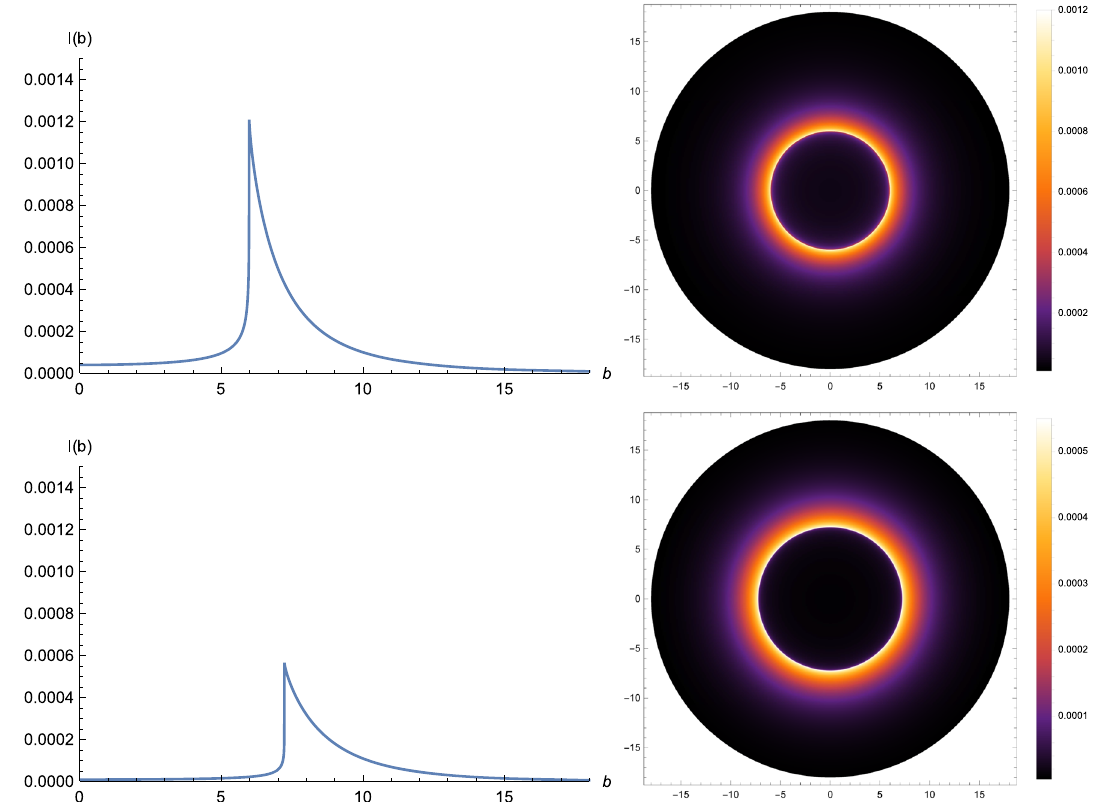
Fig. 8 Profiles of the specific intensity I ( b ) cast by an infalling spherical accretion, viewed face-on by an observer near the cosmological horizon. We set M = 1, a = 0 . 05, w = − 0 . 5 (top row) and w = − 0 . 7 (bottom row) as two examples. The details can be seen in the main